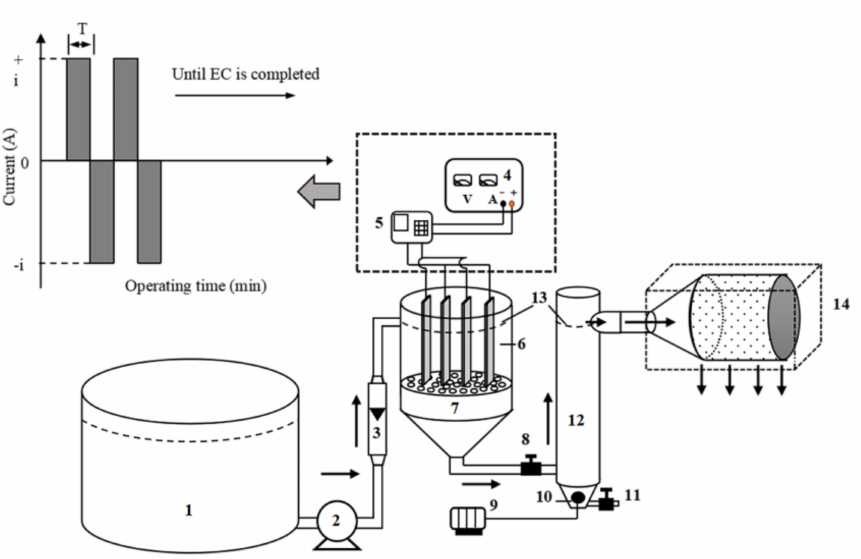
Figure 1. The structural diagram of the EC − filtration system: (1) water storage tank, (2) water pump, (3) liquid flowmeter, (4) DC power supply, (5) programmable time relay, (6) electrodes, (7) EC reactor, (8) valve, (9) air pump, (10) airstone, (11) drain valve, (12) buffer, (13) liquid level, and (14) microscreen drum